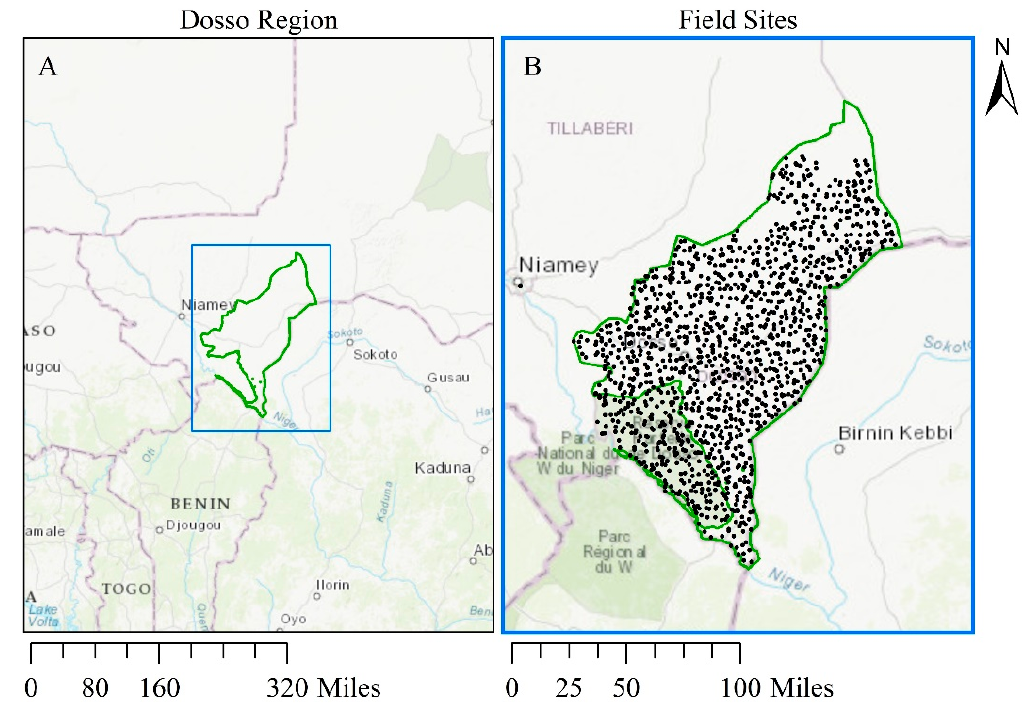
Figure 1. ( A ): Boundary of the Dosso region of Niger. Dosso reserve has been removed from Land Capability Classification assessment as it is not considered potential agricultural land, and ( B ): 1305 soil sampling field sites in the Dosso